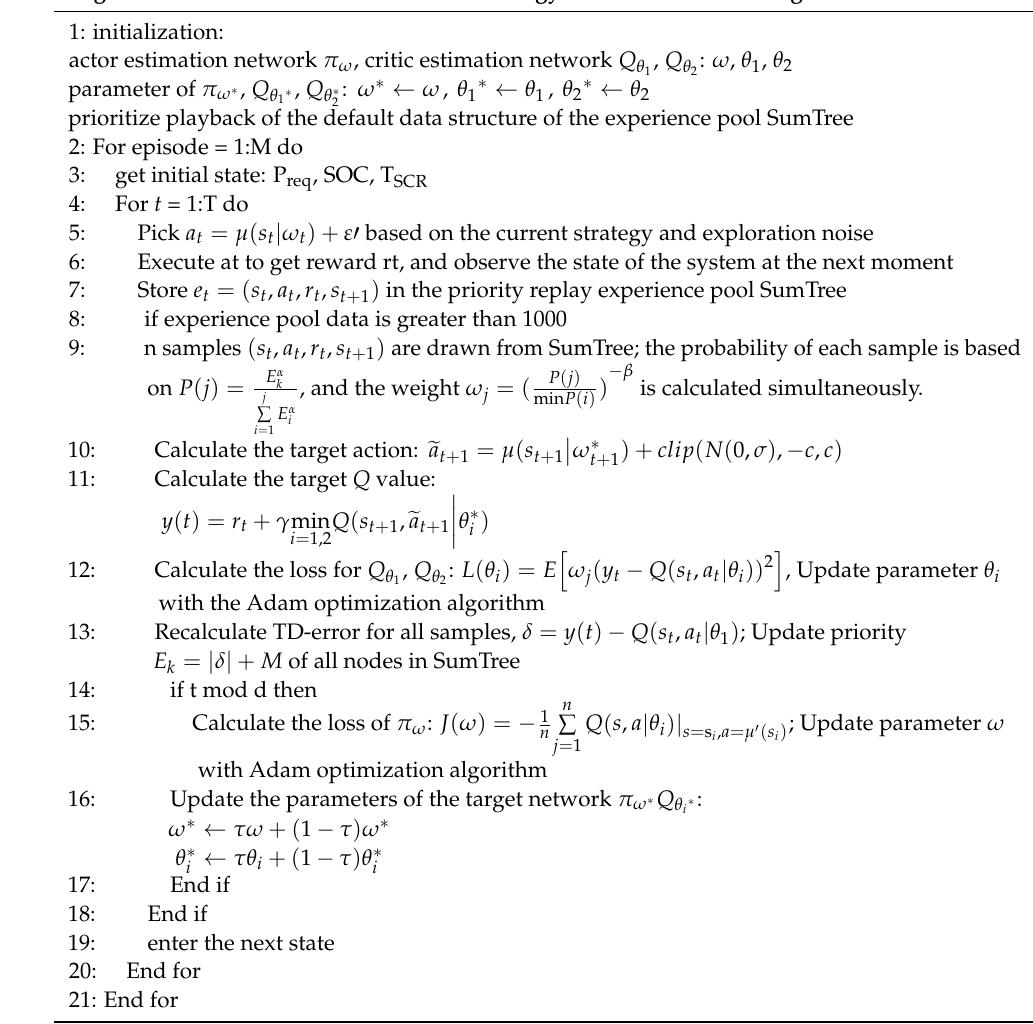
Algorithm 1. Calculation Process of the Strategy Based on PER-TD3